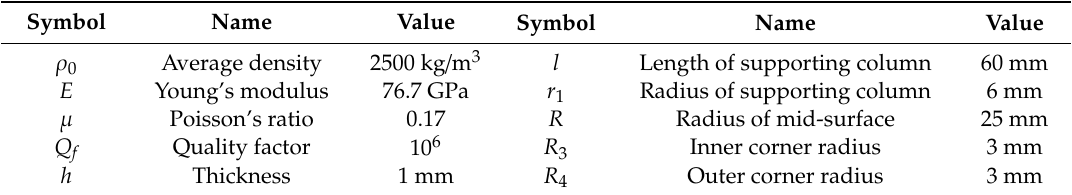
Table 1. Geometric and physical parameters of resonator made of fused